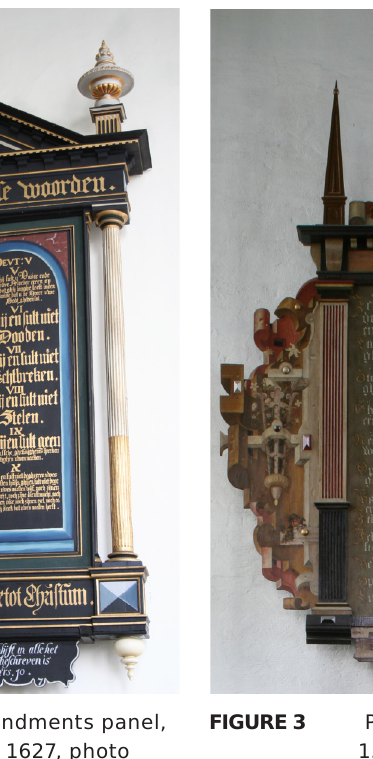
Ten Commandments panel, Beusichem, 1627, photo archive Regnerus Steensma.